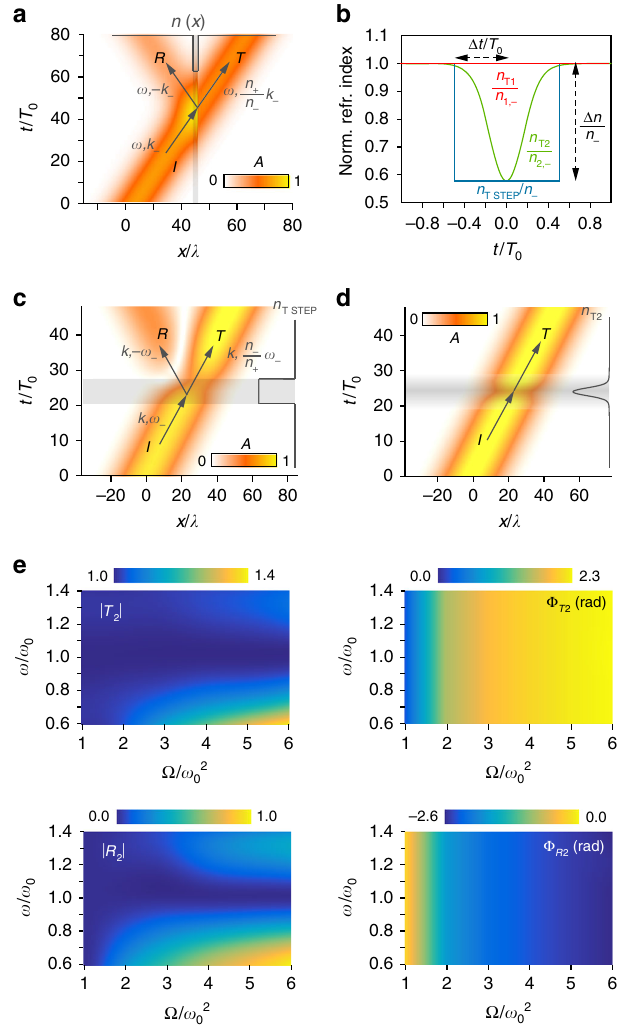
Fig. 2 Re fl ectionless all-dielectric (all-magnetic) T-SUSY time-varying optical media. a Example of spatial re fl ection for an optical beam going through a time-invariant spatial step-index medium (see